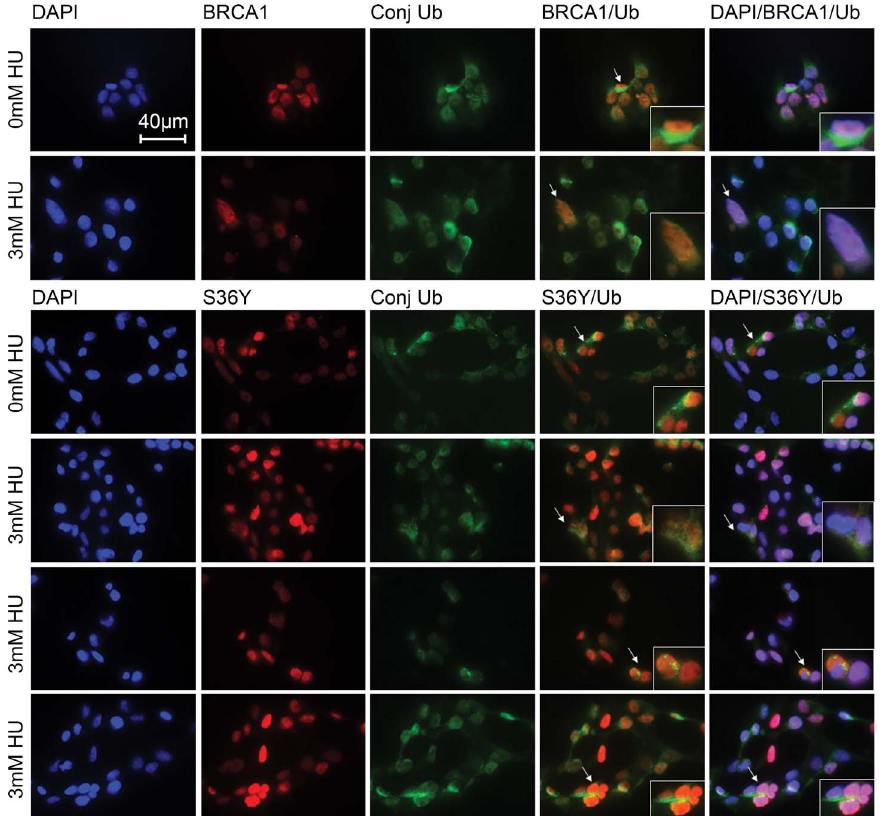
Figure 5. p.Ser36Tyr (S36Y) BRCA1 variant exhibits diminished co-localization with conjugated ubiquitin foci in HU treated cells. Immunofluorescence analysis of transfected, S-phase synchronized cells demonstrated that the p.Ser36Tyr BRCA1 variant fails to co-localize with conjugated ubiquitin detected by the FK2 antibody that recognizes only conjugated ubiquitin structures. A high proportion of p.Ser36Tyr BRCA1 and conjugated ubiquitin were detected outside the nucleus similar to wild type transfected cells. HU treatment induced mobilization and co-localization of wild type BRCA1 and conjugated ubiquitin in the nuclei of transfected cells. Contrary to the wild type transfected cells, HU treatment did not induce p.Ser36Tyr nuclear mobilization to the same levels and in many cells the p.Ser36Tyr protein did not co-localize with conjugated ubiquitin foci. Three different locations are shown for the p.Ser36Tyr variant following treatment with HU. Nuclei were stained with DAPI. The forth column is the merge of BRCA1 and conjugated ubiquitin and where green and red signals overlap a yellow signal is seen indicating co-localization. The fifth column is the merge of all stains. Where all signals overlap a white signal is seen, where red and blue signal overlap a pink signal is seen and where green and blue signals overlap a violet signal is seen indicating co-localization. p.Cys61Gly (C61G) and empty vector (EV) control are displayed in Supporting Fig. 3). Statistical analysis confirmed that the observed effects are significant (p , 0.05). Insets show the arrow pointed cells following enlargement. The results are representative of 3 experiments. Scale bar: 40 m